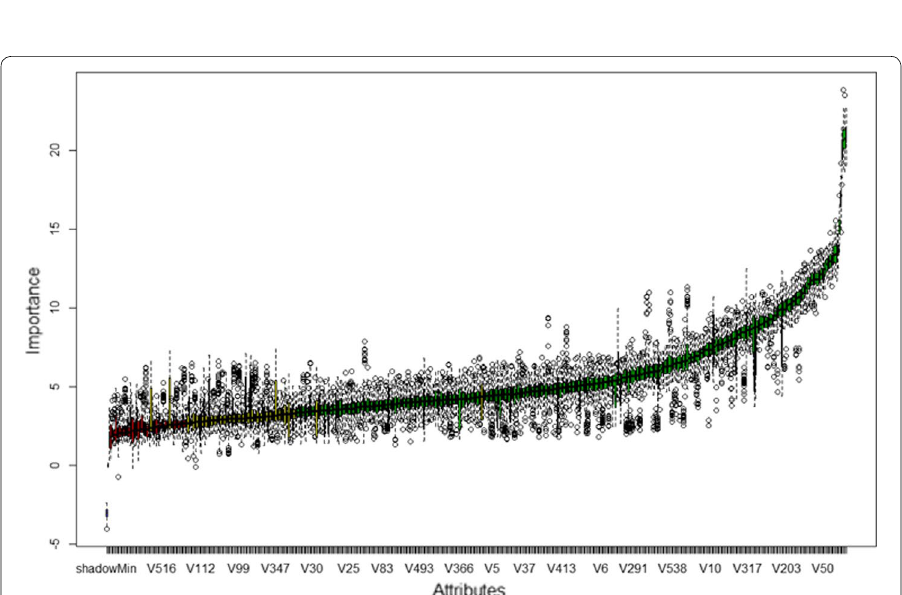
Fig. 12 The important measure for each variable of Human Activity Recognition Using Smartphones Dataset using